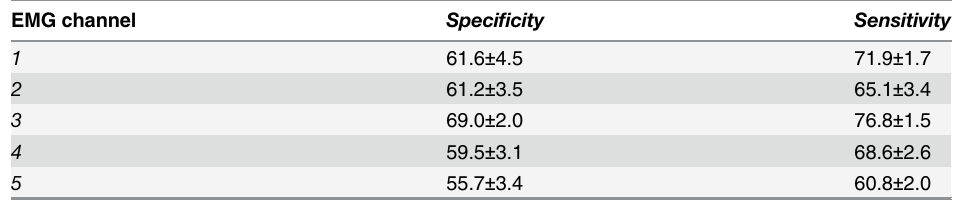
Fig 15. Classification results (mean value of the 10-fold for error rate, sensitivity and specificity) for all channels of speaker 1. These results are based on four additional sessions from this speaker recorded a posteriori. Error bars show a 95% confidence interval. doi:10.1371/journal.pone.0127040.g015 Table 8. Mean sensitivity and specificity measures (%) with a 95% confidence interval for each EMG channel of speaker